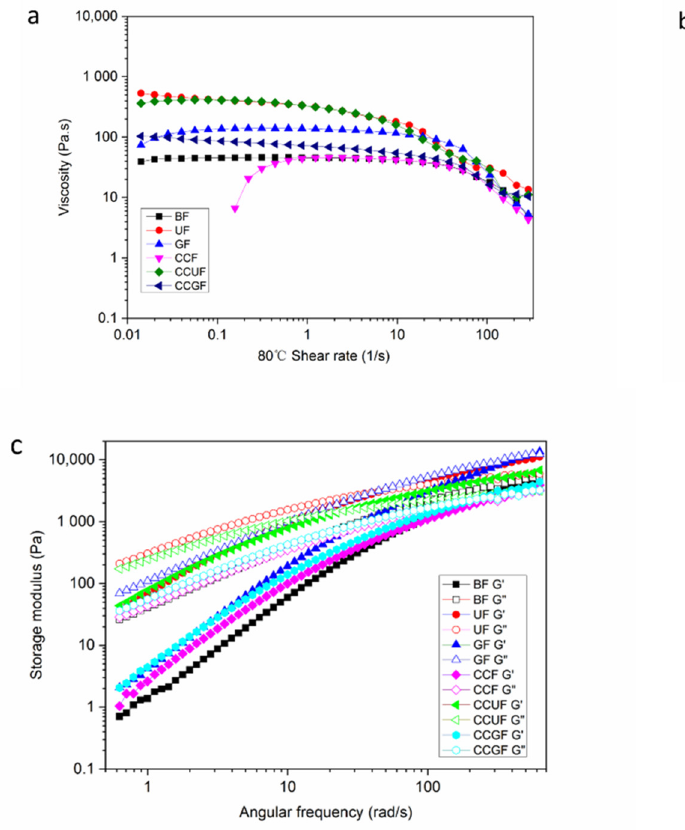
Figure 8. The viscosity ( a ) and shear stress ( b ) of cellulose solution systems with different dissolution behaviors, angular frequency on storage modulus (G’) and loss modulus (G”) of cellulose-IL viscose systems at 80 °C ( c ).